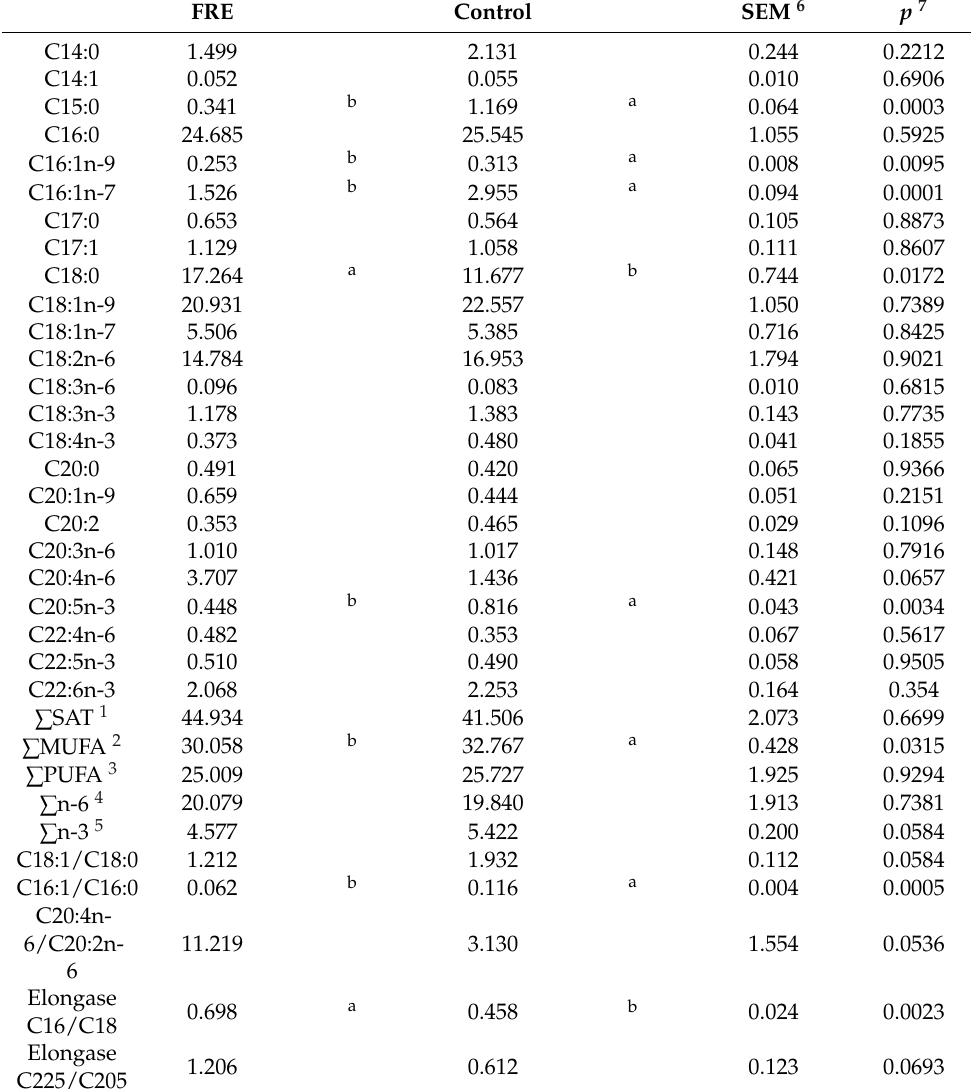
Table 4. Fatty acid profile (g/100 g of total fatty acids) in the faeces from the FRE (food-responsive enteropathy) and control